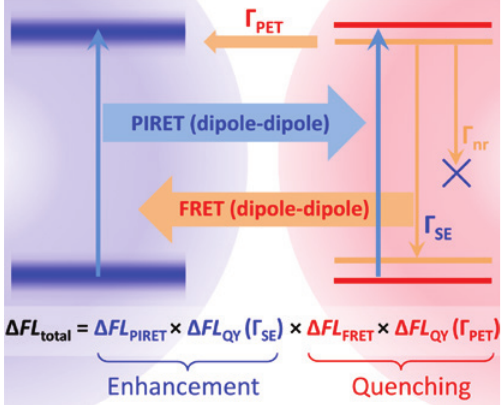
Figure 8: Diagram illustrating possible fluorescence enhancement and quenching mechanisms in a metal-semiconductor system. The near-field energy exchange between electrical dipoles of the plasmon and semiconductor permits both forward (PIRET) and backward (FRET) direction of the energy transfer. The fluorescence of the semiconductor dye is also affected by plasmon-induced changes in the fluorescence QY. These include both the QY enhancement due to the plasmon-induced increase in the radiative decay rate Γ (SE) SE and the QY reduction due to the backward transfer of photoinduced charges to metal ( Γ PET